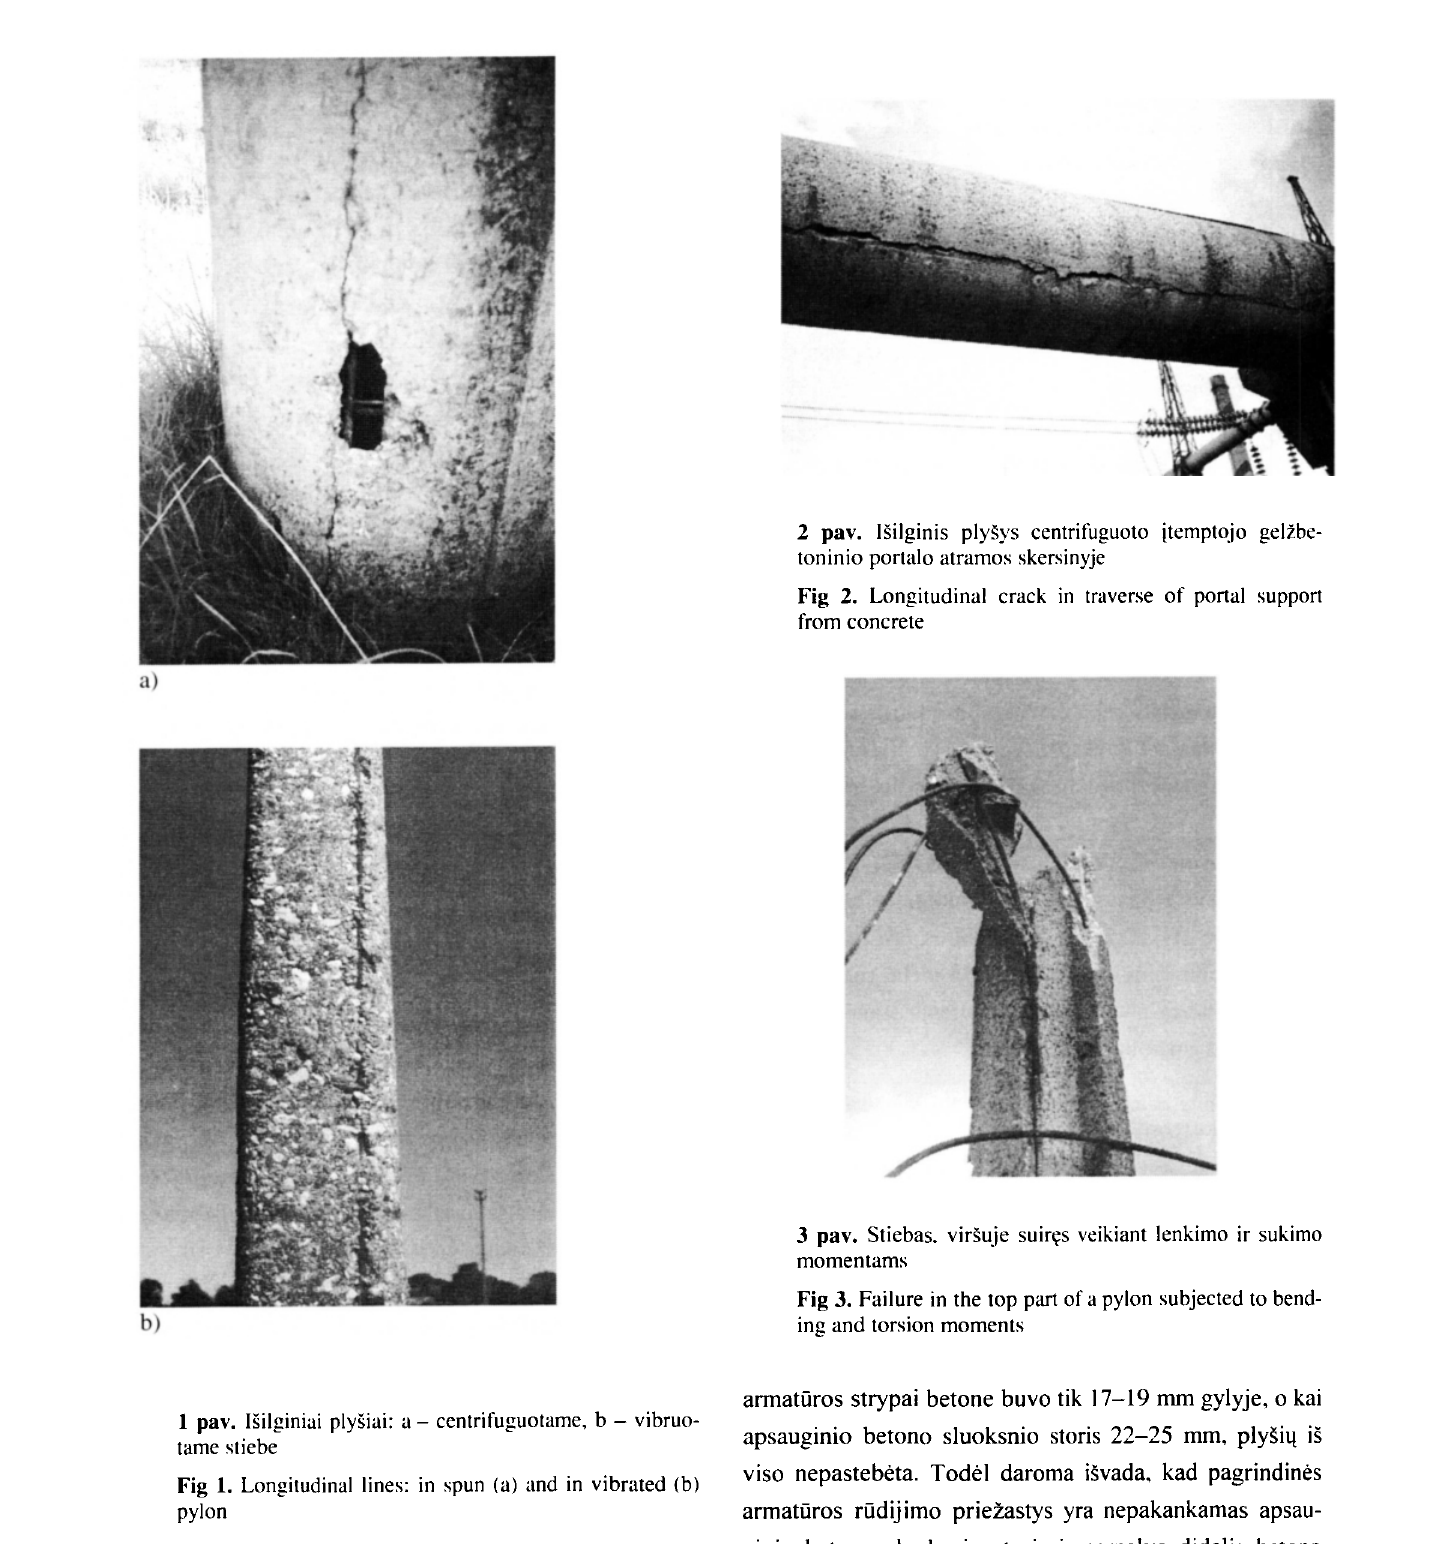
Fig 1. Longitudinal lines: in spun (a) and in vibrated (b) pylon